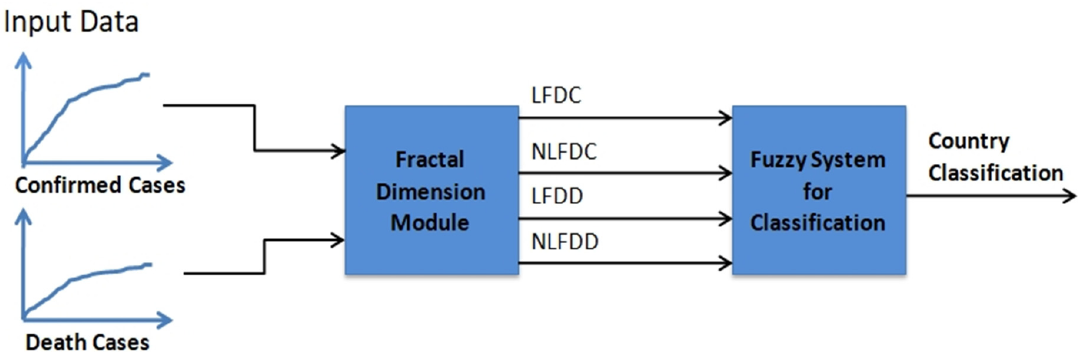
Figure 2. Proposed method with the fractal dimension module and the fuzzy system.